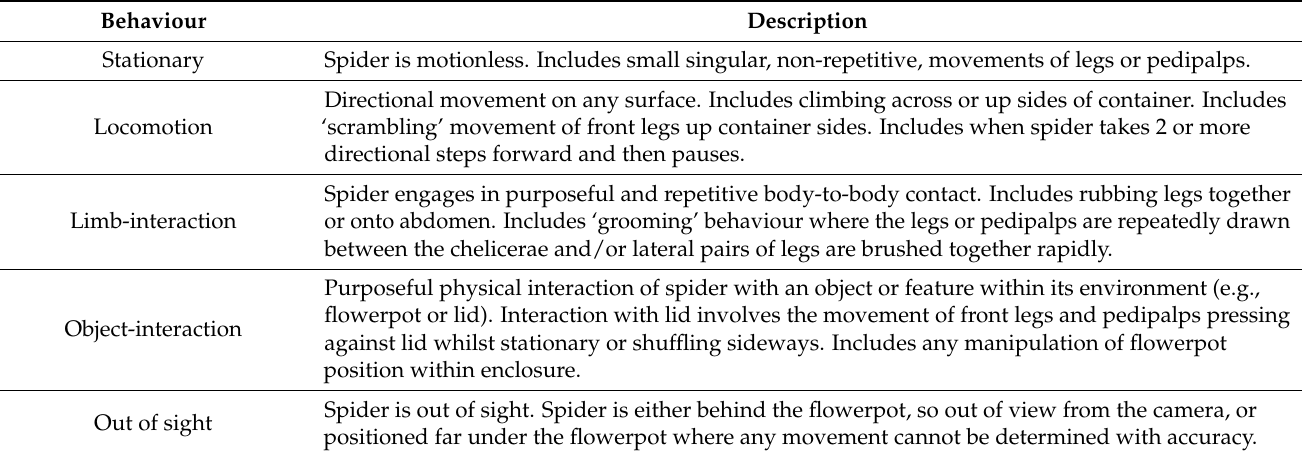
Table 1. Ethogram of key state behaviours exhibited by captive female Brachypelma hamorii at ZSL London